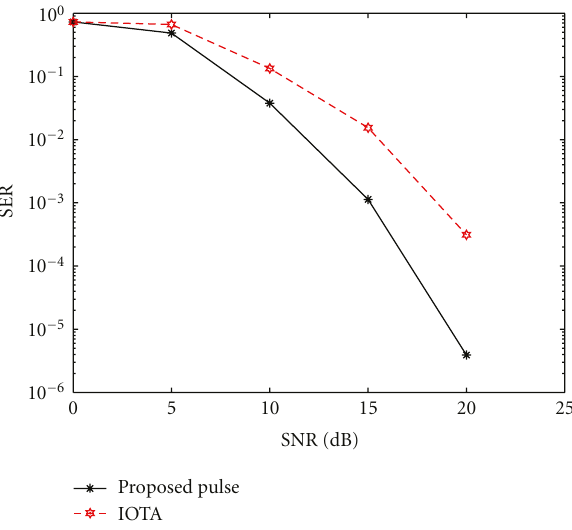
Figure 5: Pulse-shapes in the frequency domain for symbol rate 12.19 M/sec.